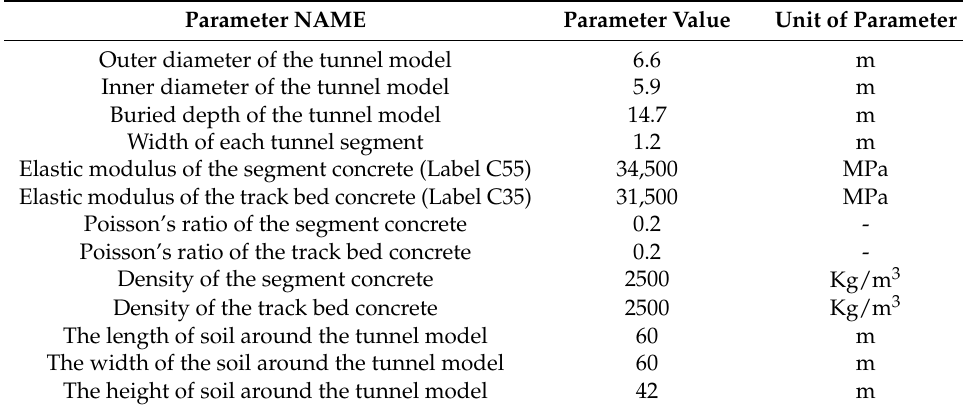
Table 2. Soil parameters of the tunnel model.